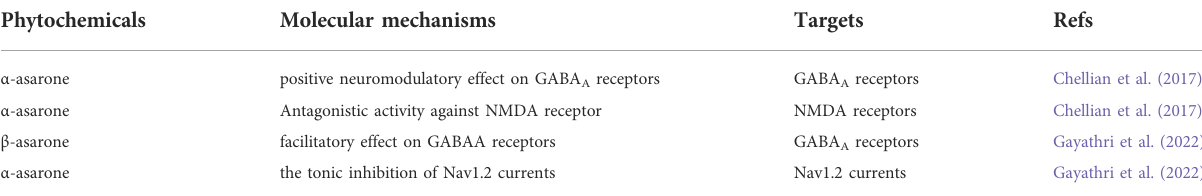
TABLE 6 The targets and mechanisms of VOA in